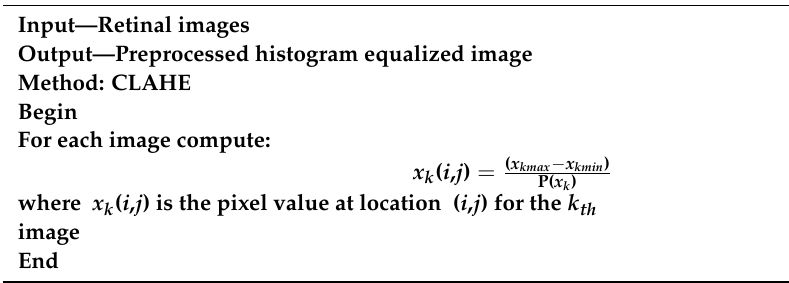
Algorithm 1: Histogram equalization algorithm.